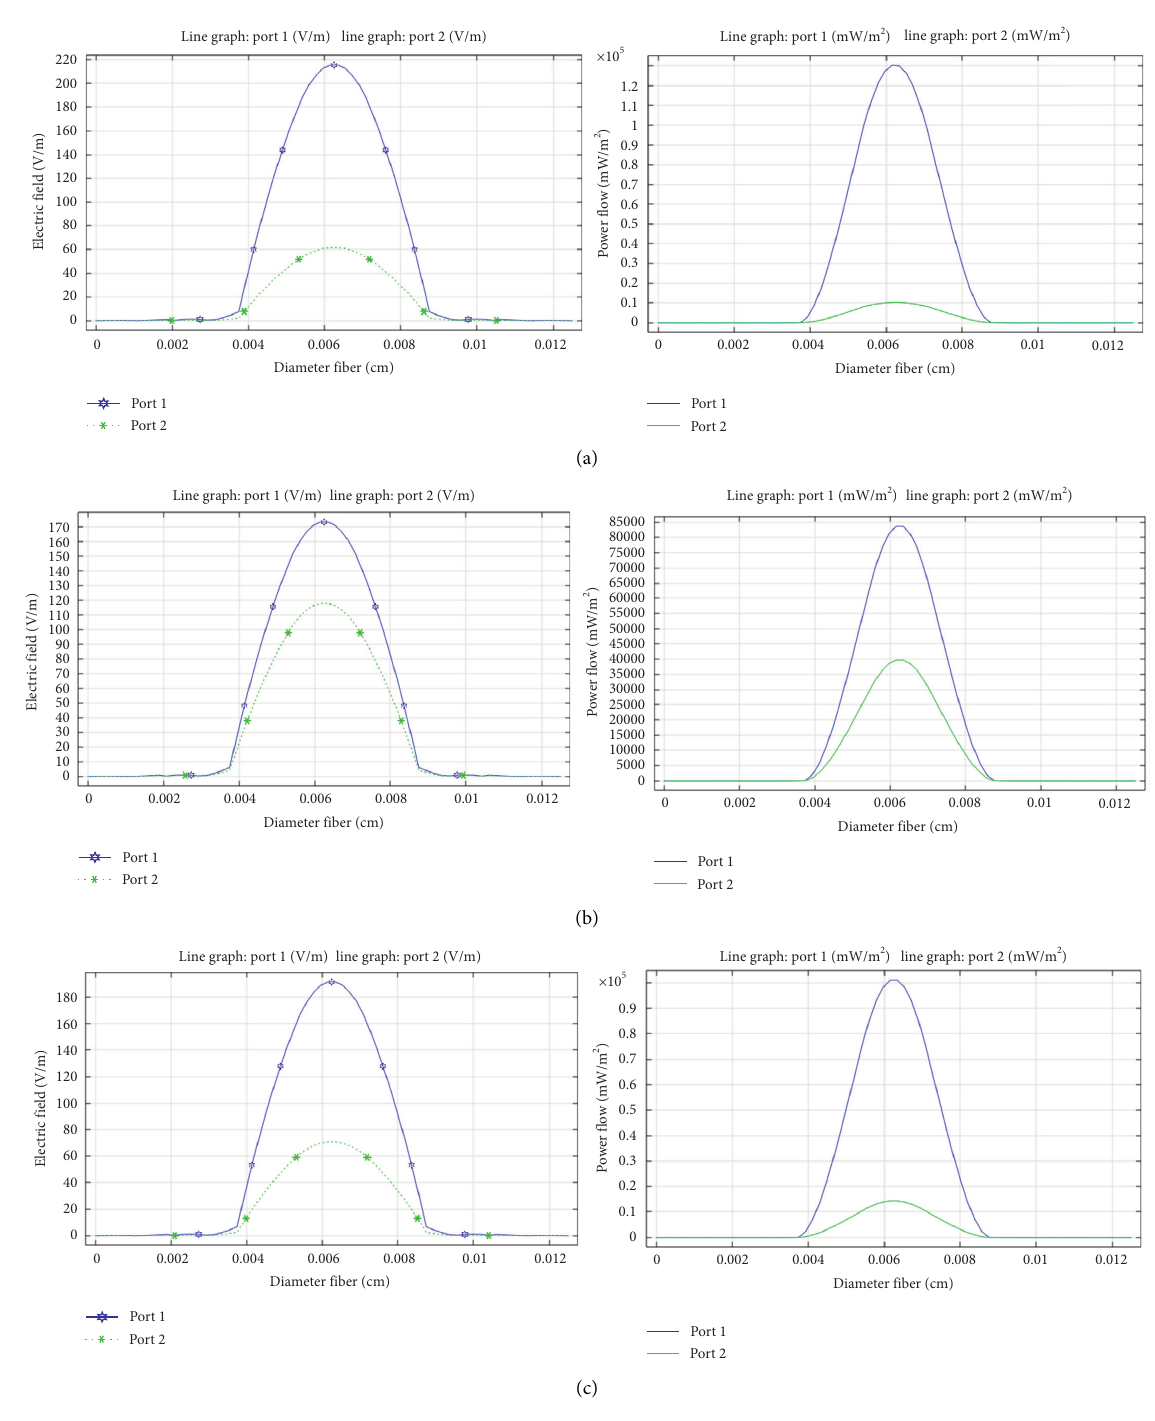
Figure 3: Graph of electric field and power flow at Port 1 (input) and Port 2 (output) when the refractive index of cladding is � 1.4612, (b) n � 1, and (c) n � (a) n silica air ZnO